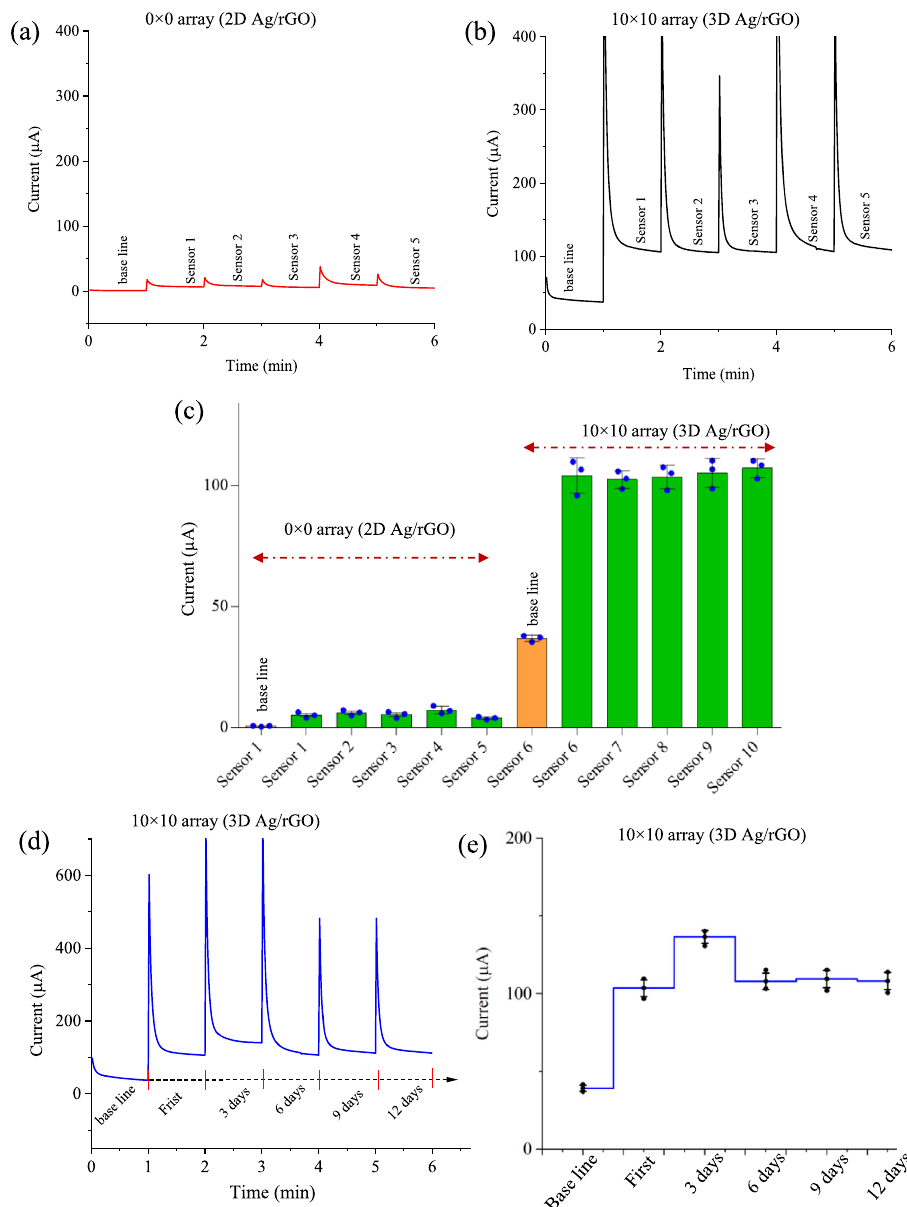
Fig. 8 Reproducibility and stability tests of the multi-length-scale sensing platform. Five different sensors for each con fi guration (2D Ag/rGO and 3D Ag/rGO) were fabricated using the process developed in this work and tested with the same parameters in pbs solution with 1 m M of ferro/ferricyanide for 2D Ag/rGO electrode ( a ) and 3D Ag/rGO micropillar array electrode ( b ). The dopamine concentration was set to 20 µ M for 2D Ag/rGO sensors